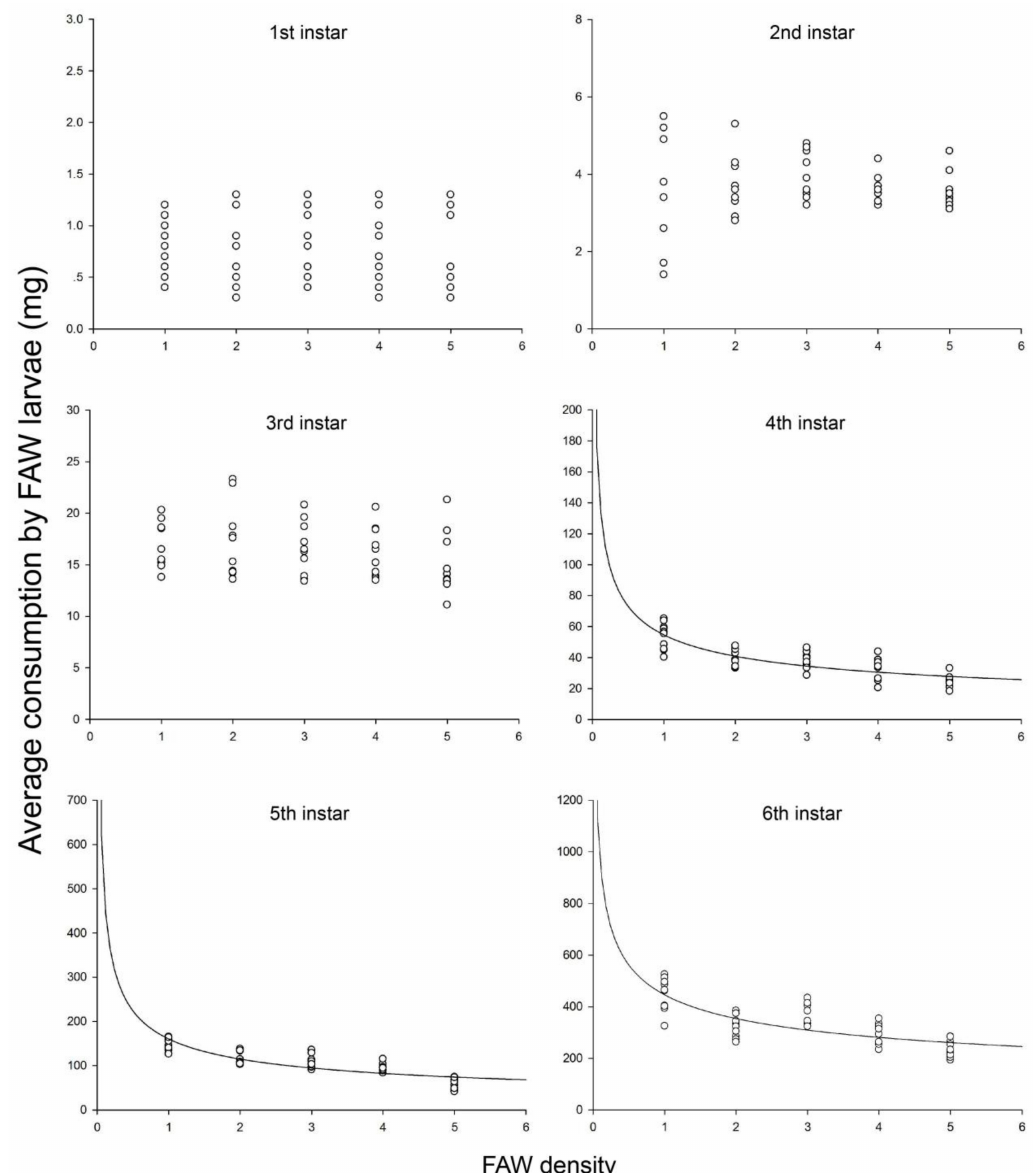
Figure 2. Intraspecific competition among the FAW larvae at each stage. Each data point represents the mean consumption by the FAW larvae at each FAW density. Curves were fitted using the intraspecific competition equation (Equation